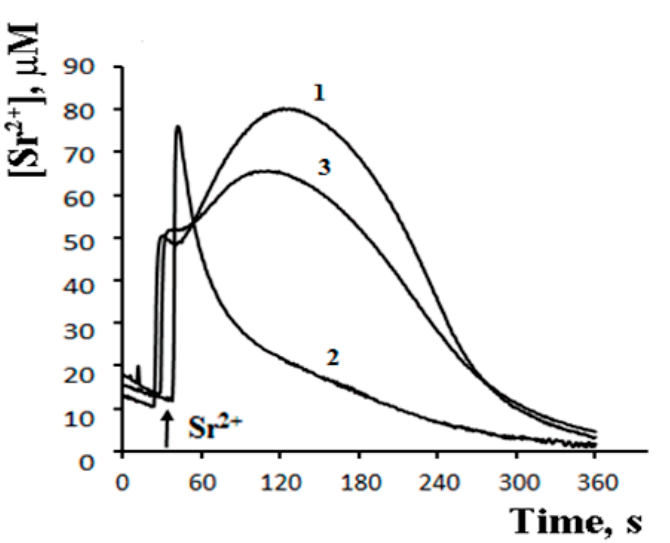
Figure 6. Palmitic acid re-induces the Sr 2+ -induced permeability transition suppressed by the Ca 2+ - dependent phospholipase A 2 inhibitor—AACOCF 3 . The medium contained 20 mM sucrose, 1 mM KCl, 1 µ M TPP + , 1 µ M CsA, 5 mM succinic acid/Tris (pH 7.3). Addition: 40 nmol SrCl 2 /mg of pro-